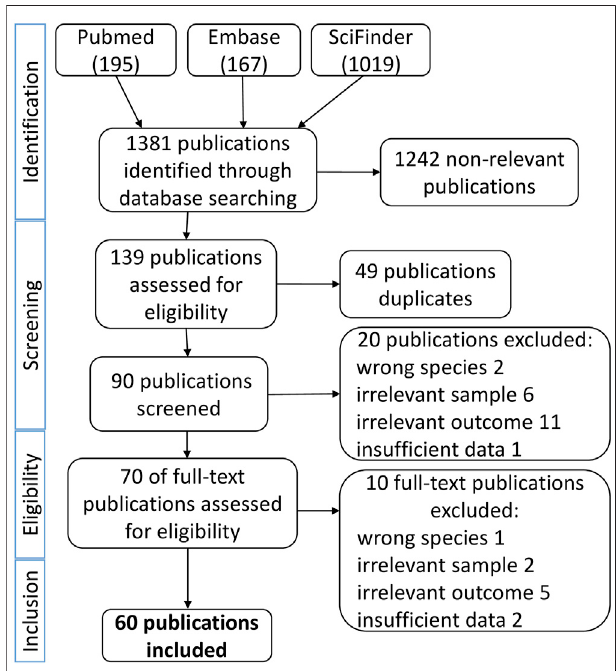
FIGURE 1 | Methodological work fl ow from the databases to the fi nal publicationsselectedtobeincludedinthisreviewbasedonde fi nedkeywords and exclusion criteria (see section Materials and Methods